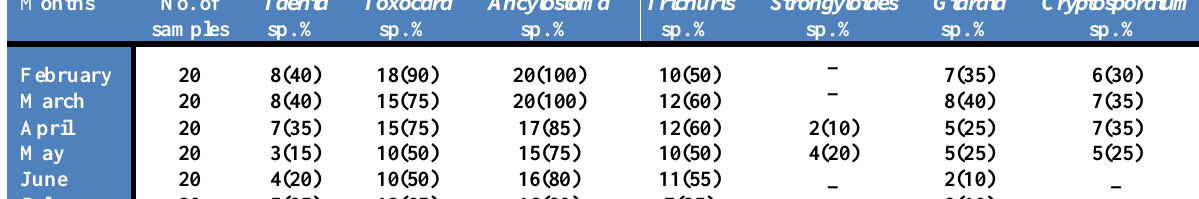
Toxocara Trichuris Strongylo. Gairdia